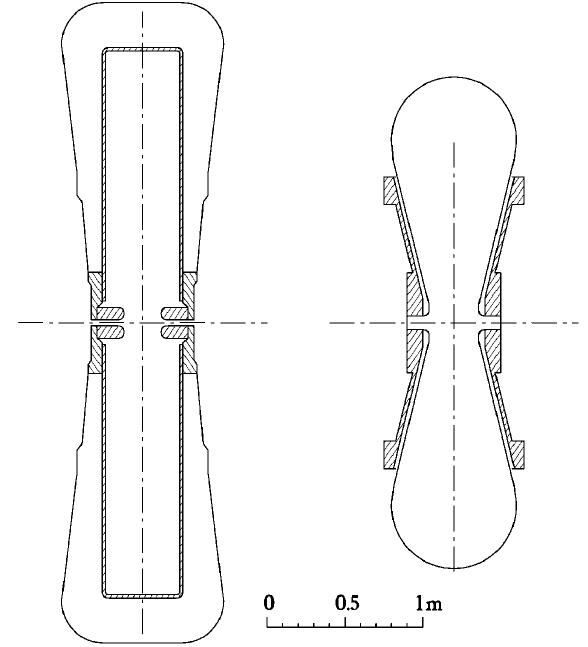
FIG. 1. Cross section of two different designs for accelerating cavities. On the left, the original design that is presently in operation; on the right, the future design. The plane of these two cross sections is perpendicular to the accelerator midplane and tangential to the orbit of the accelerated particles. Both cavities extend prismatically in the radial direction over approximately 3.3